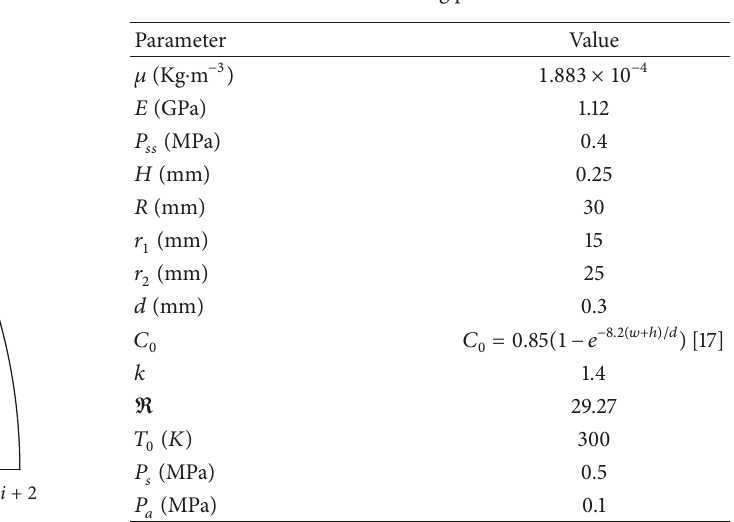
Figure 3: 4-order finite difference scheme in polar coordinates.